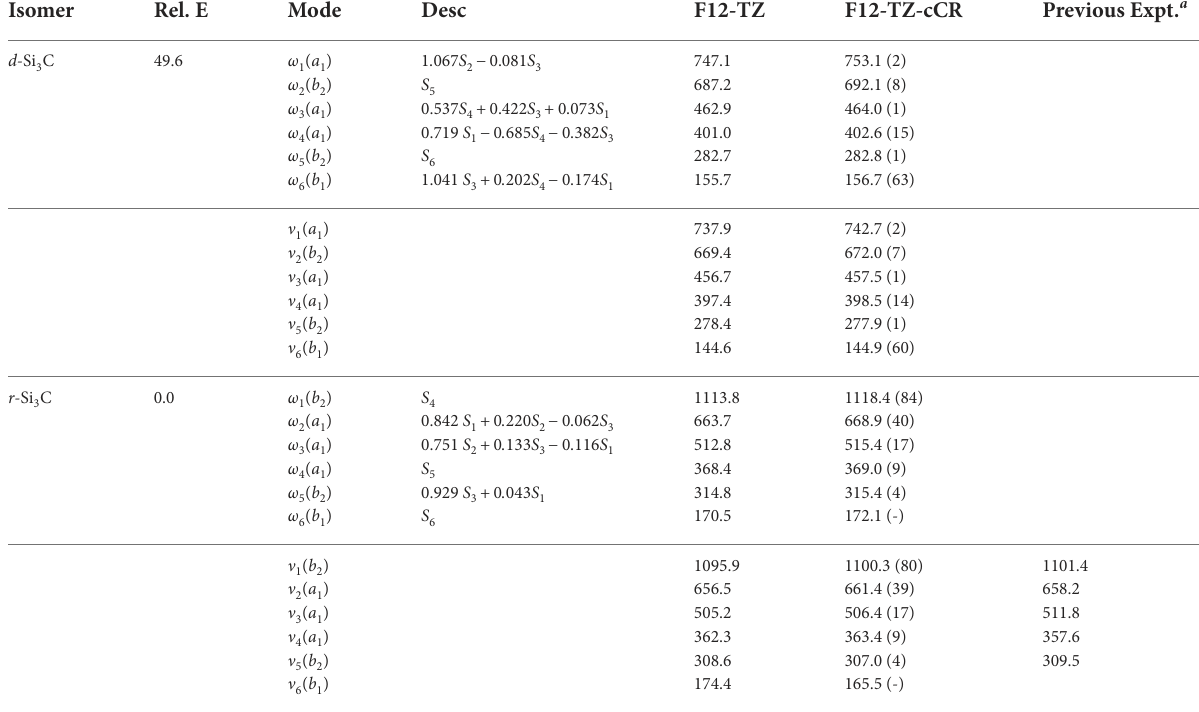
TABLE 7 Harmonic ( ω ) andFundamental ( ν ) VibrationalFrequencies(incm −1 )withIntensities(inkm mol −1 ,inParentheses)andRelativeEnergies(in kcal mol −1 )forSi 3 CIsomers.Modedescriptions(Desc.)refertotheSICsinEqns.1-24.